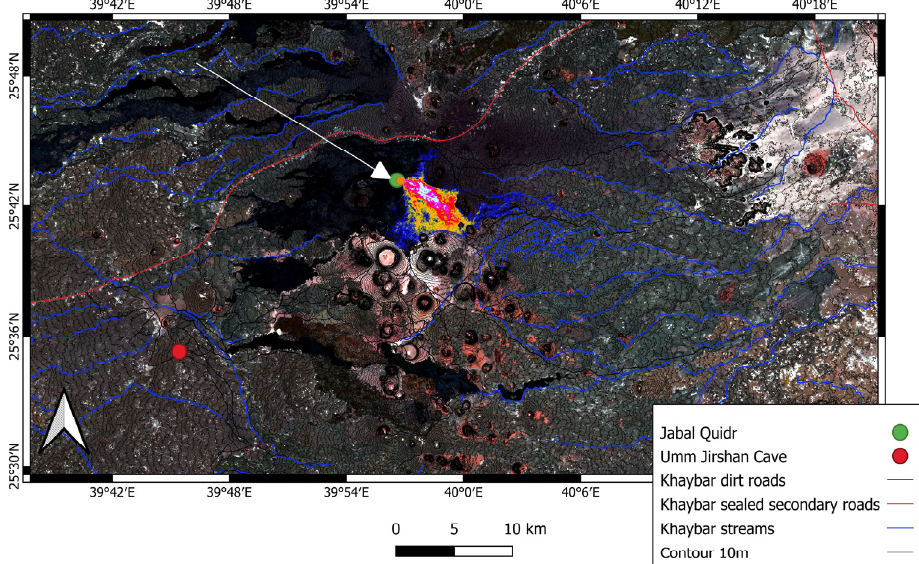
Figure 18. JQ1 vent (green dot just below the summit of Jabal Quidr marked by green dot) using 5 m (10 m) Euclidean simulation with 80 km simulation distance. Results overlay the SWIR satellite image of the region. Red dots mark the Umm Jirsan lava tube. The stream network is marked in blue, while a sealed road crossing the region is marked by a red line (data are from Open Street View).